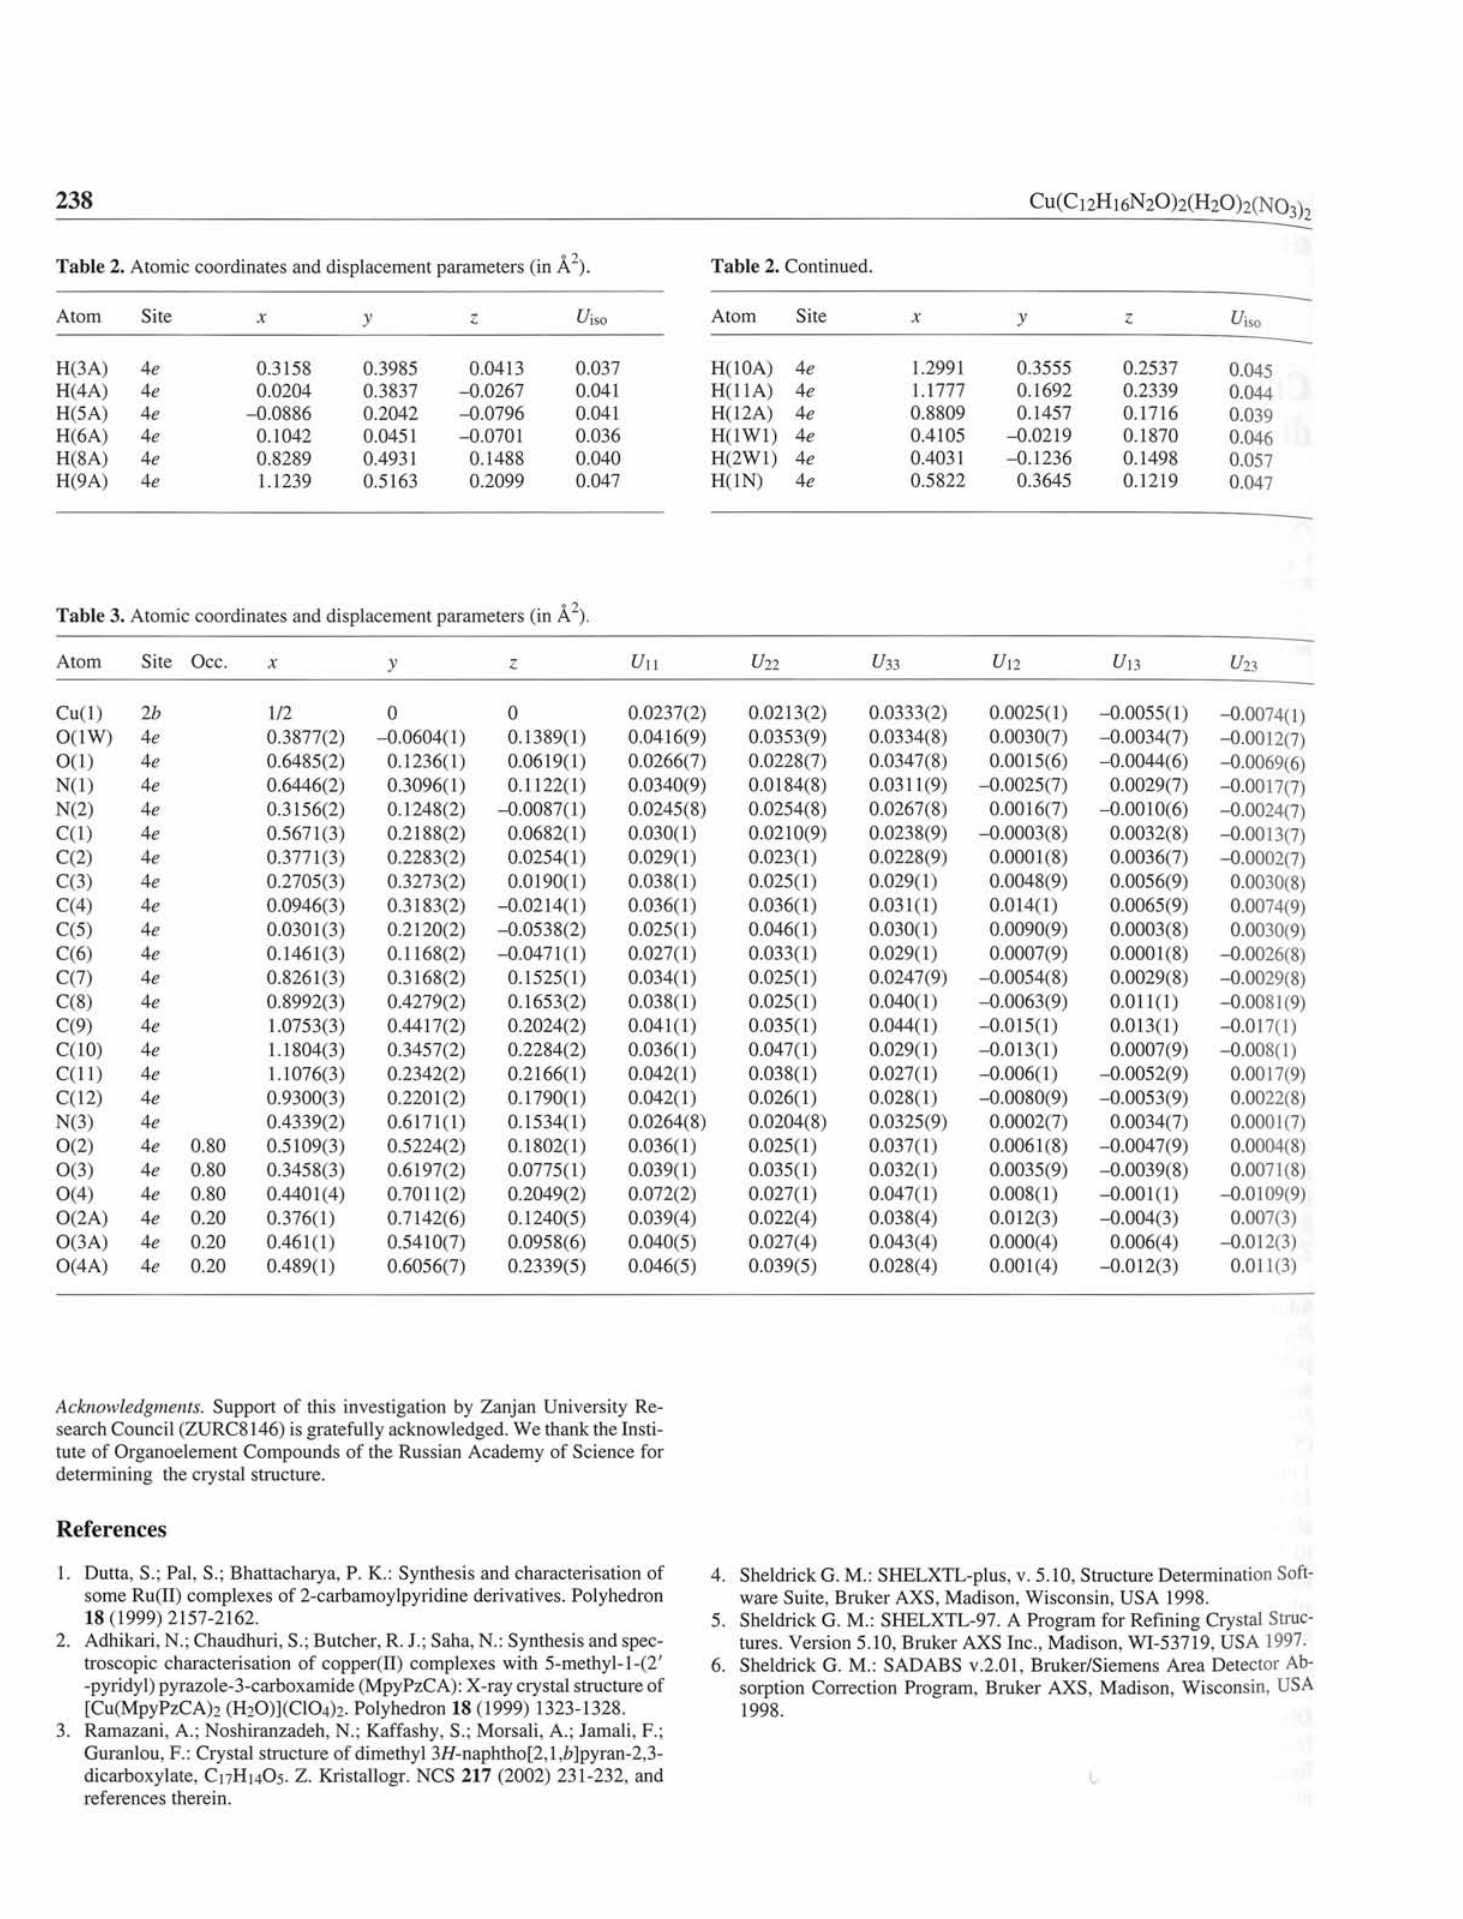
Table 2. Atomic coordinates and displacement parameters (in A").